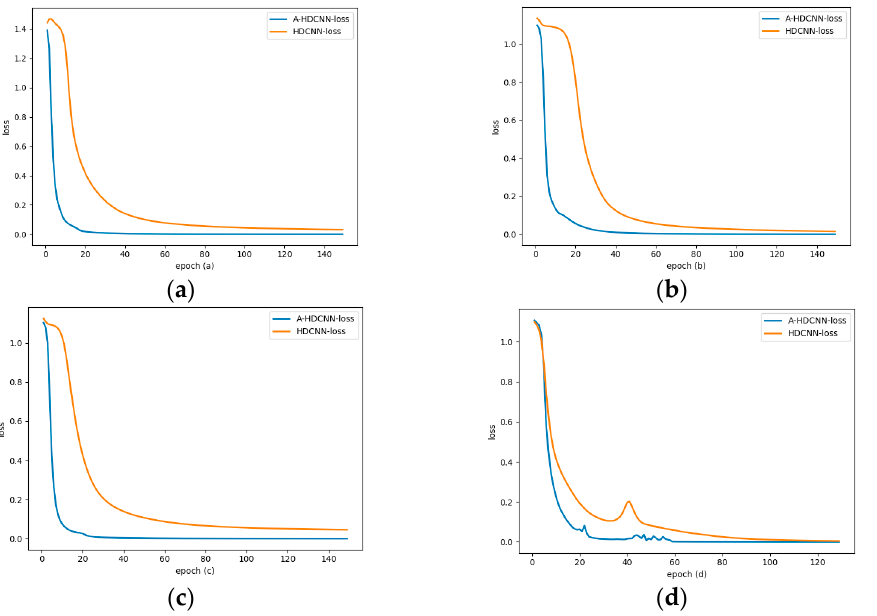
Figure 13. Error loss changes with the number of iterations: ( a ) 𝐴 − 𝐻𝐷𝐶𝑁𝑁 (cid:2869)(cid:2869) Model; ( b ) 𝐴 − 𝐻𝐷𝐶𝑁𝑁 (cid:2869)(cid:2870) Model; ( c ) 𝐴 − 𝐻𝐷𝐶𝑁𝑁 (cid:2870)(cid:2870) Model; ( d ) 𝐴 − 𝐻𝐷𝐶𝑁𝑁 (cid:2871)(cid:2870) Model.